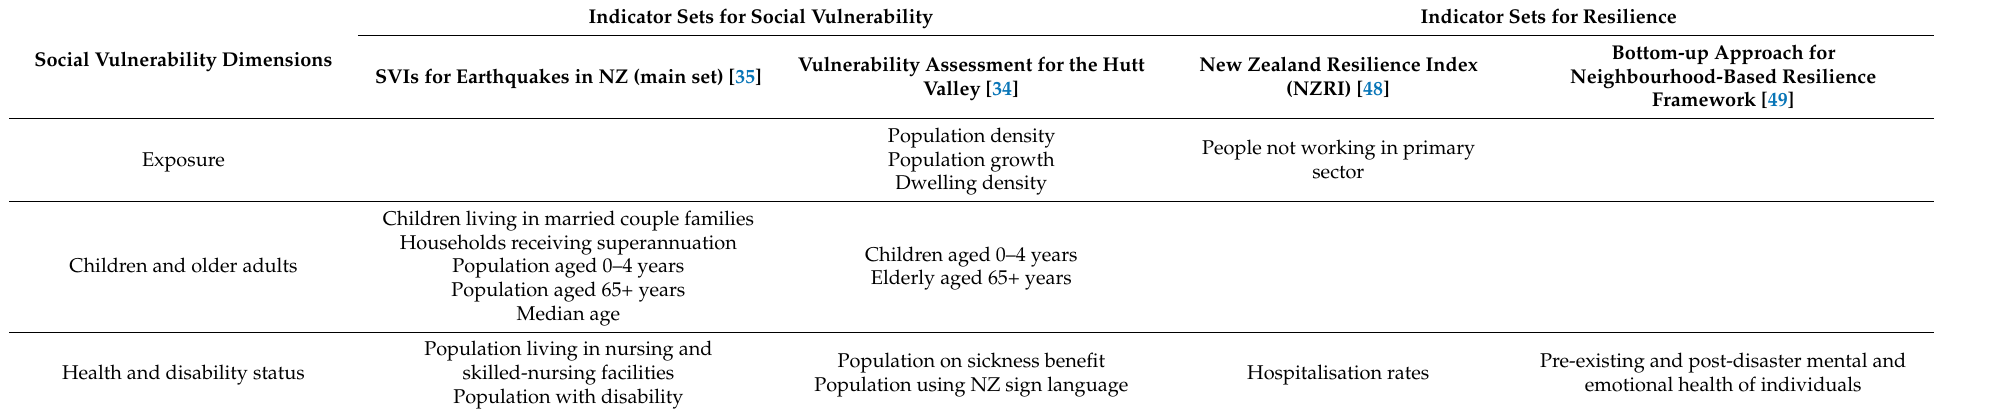
Table A2. Previous sets of social vulnerability indicators in New Zealand, by social vulnerability